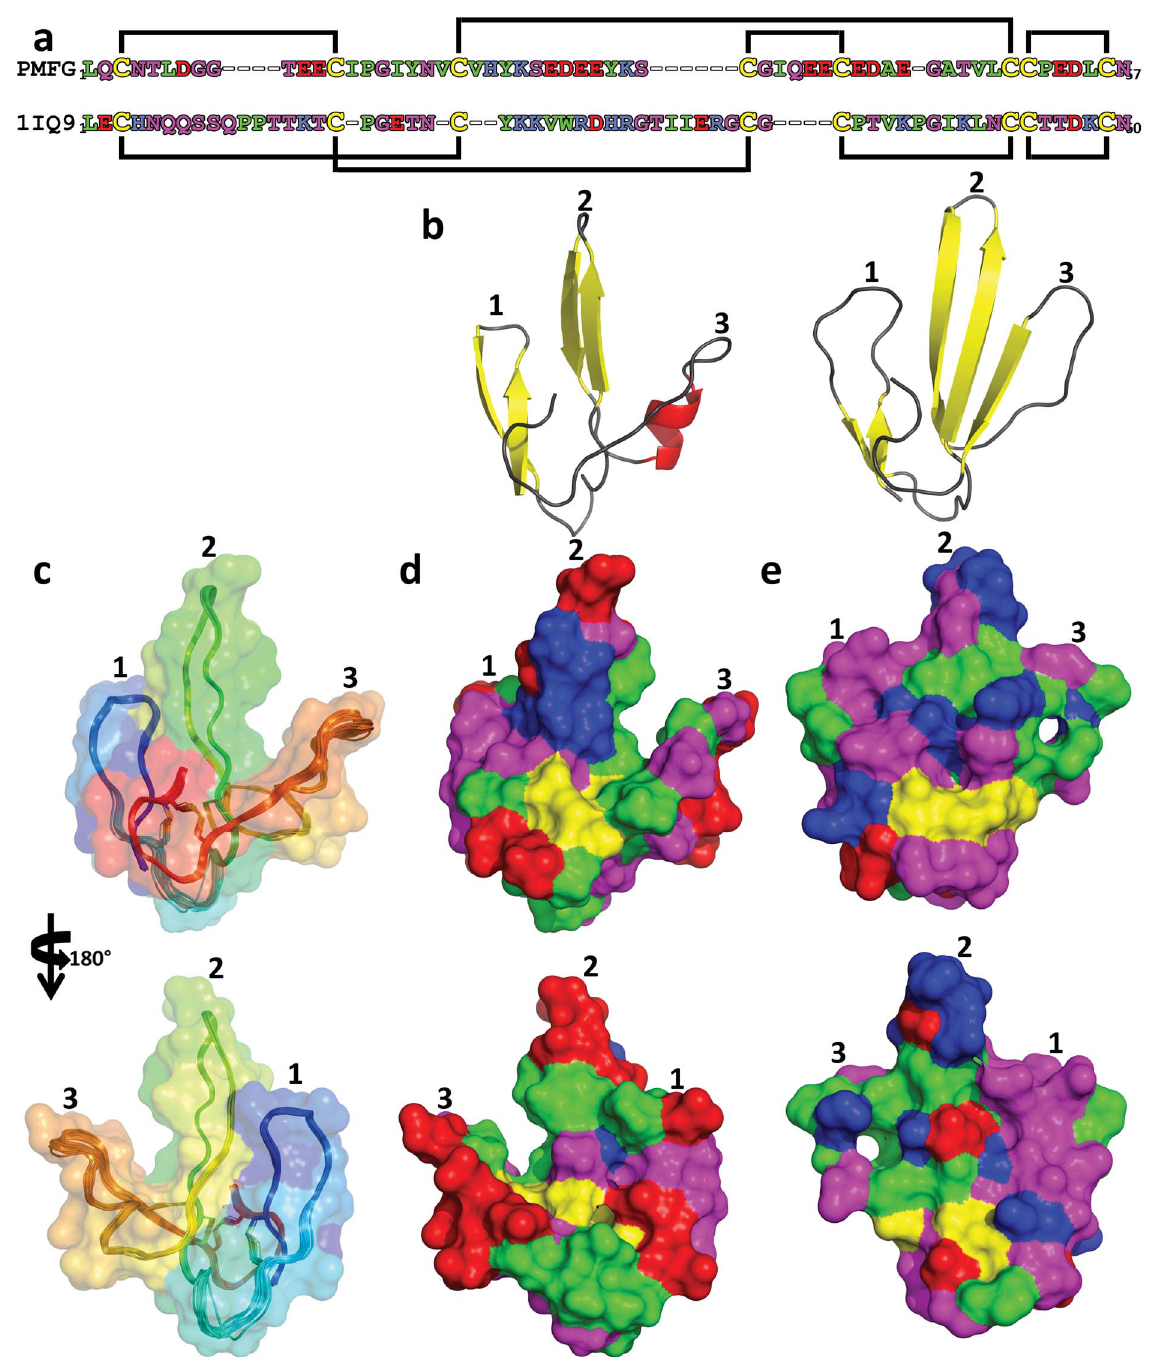
Figure 3. Surface models of PMF-G. (a) Alignment of PMF-G with a representative TFP (1IQ9), color coded by residue type (acidic, red; basic, blue; hydrophilic, purple; nonpolar, green; cysteine, yellow), with disulfide bonds denoted by the black lines; (b) secondary structure schematic comparing PMF-G (left) and a representative TFP (right; 1IQ9); (c) backbone model of PMF-G (20 lowest-energy conformers) with partially transparent surface rendering (both color coded N- to C-terminus, blue to red); (d) full surface rendering of PMF-G color coded by residue type (same color code as a); (e) surface rendering of 1IQ9 (same color code as a).